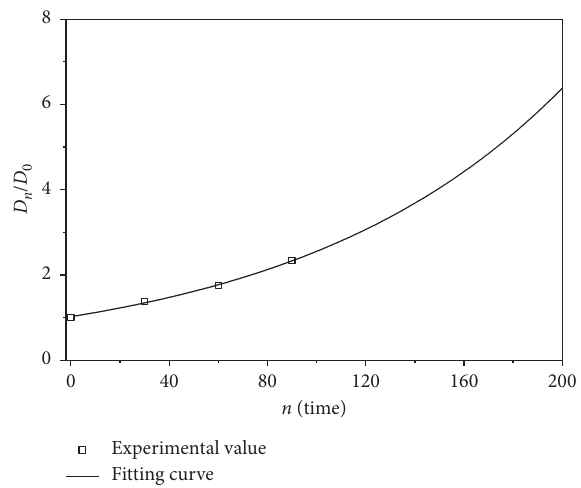
Figure 5: Variation curve of diffusion coefficient ratio D with respect to number of freeze-thaw cycles ( n